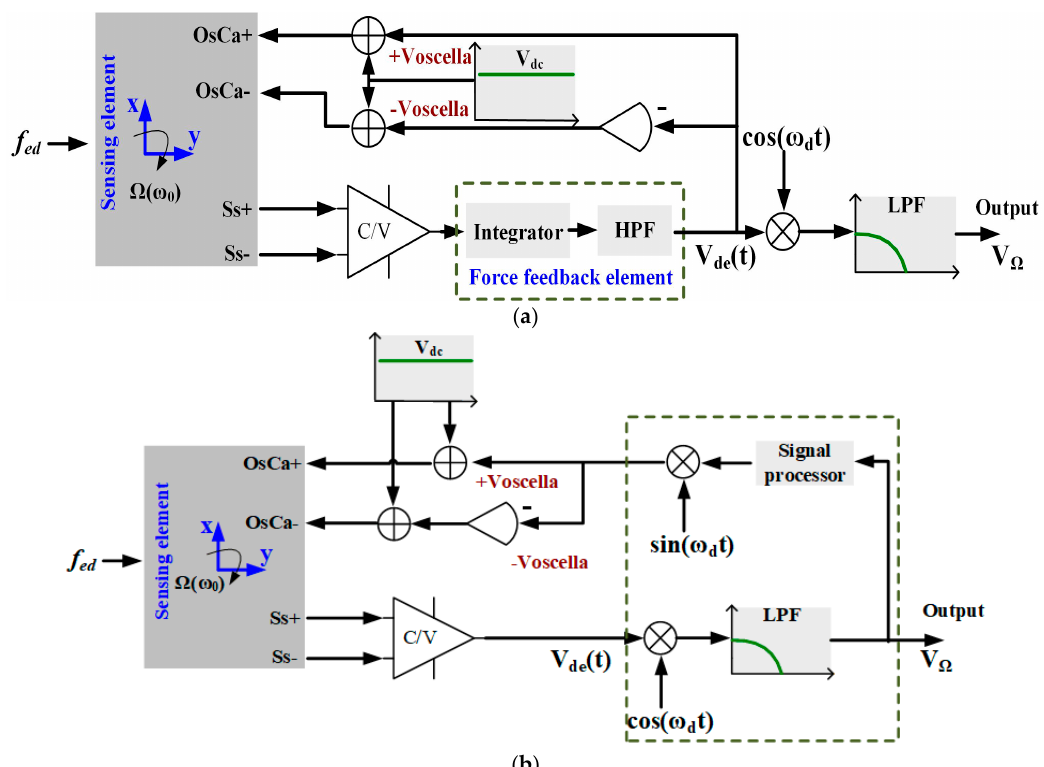
Figure 2. Schematic comparison of ( a ) the proposed force feedback control method and ( b ) the traditional method for the MCVG.